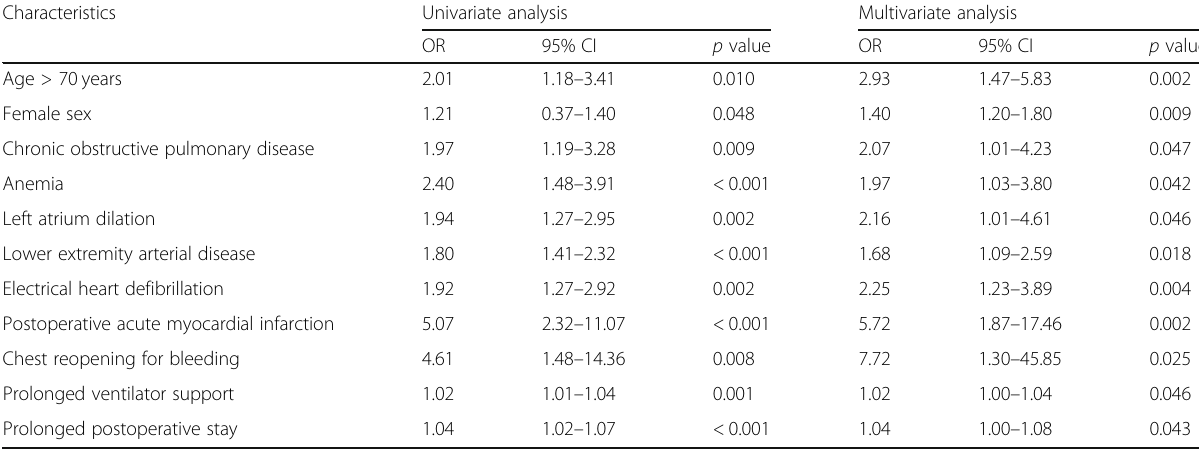
Table 3 Independent predictors of late mortality and major adverse cardiovascular and cerebral events on binary logistic regression analysis (all